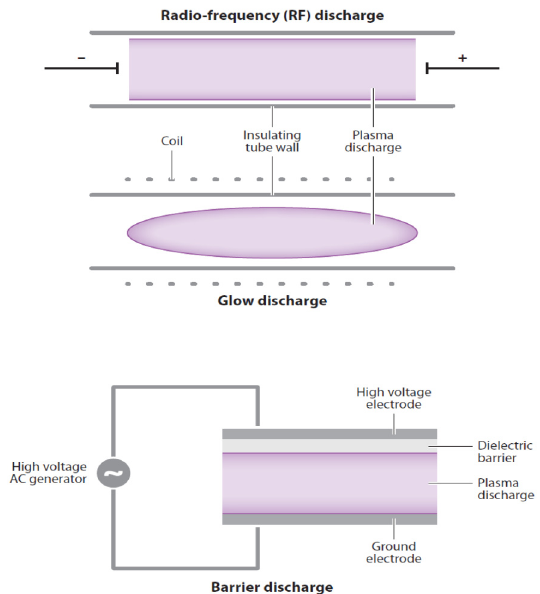
Figure 1. Diagrams of three basic types of discharge: Top—radio frequency discharge, middle—glow discharge, bottom—barrier discharge. Purple colored zones are cold plasma discharge. [8].